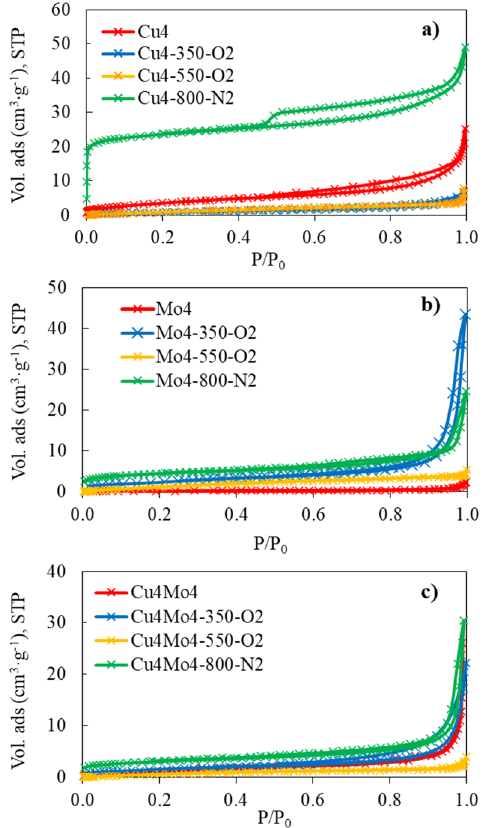
Figure 3. N 2 adsorption–desorption isotherms at − 196 °C of the catalysts of the ( a ) Cu series, ( b ) Mo series, and ( c ) CuMo series. Main textural properties of the prepared catalysts obtained from the N 2 adsorp- tion/desorption isotherms at − 196 ◦